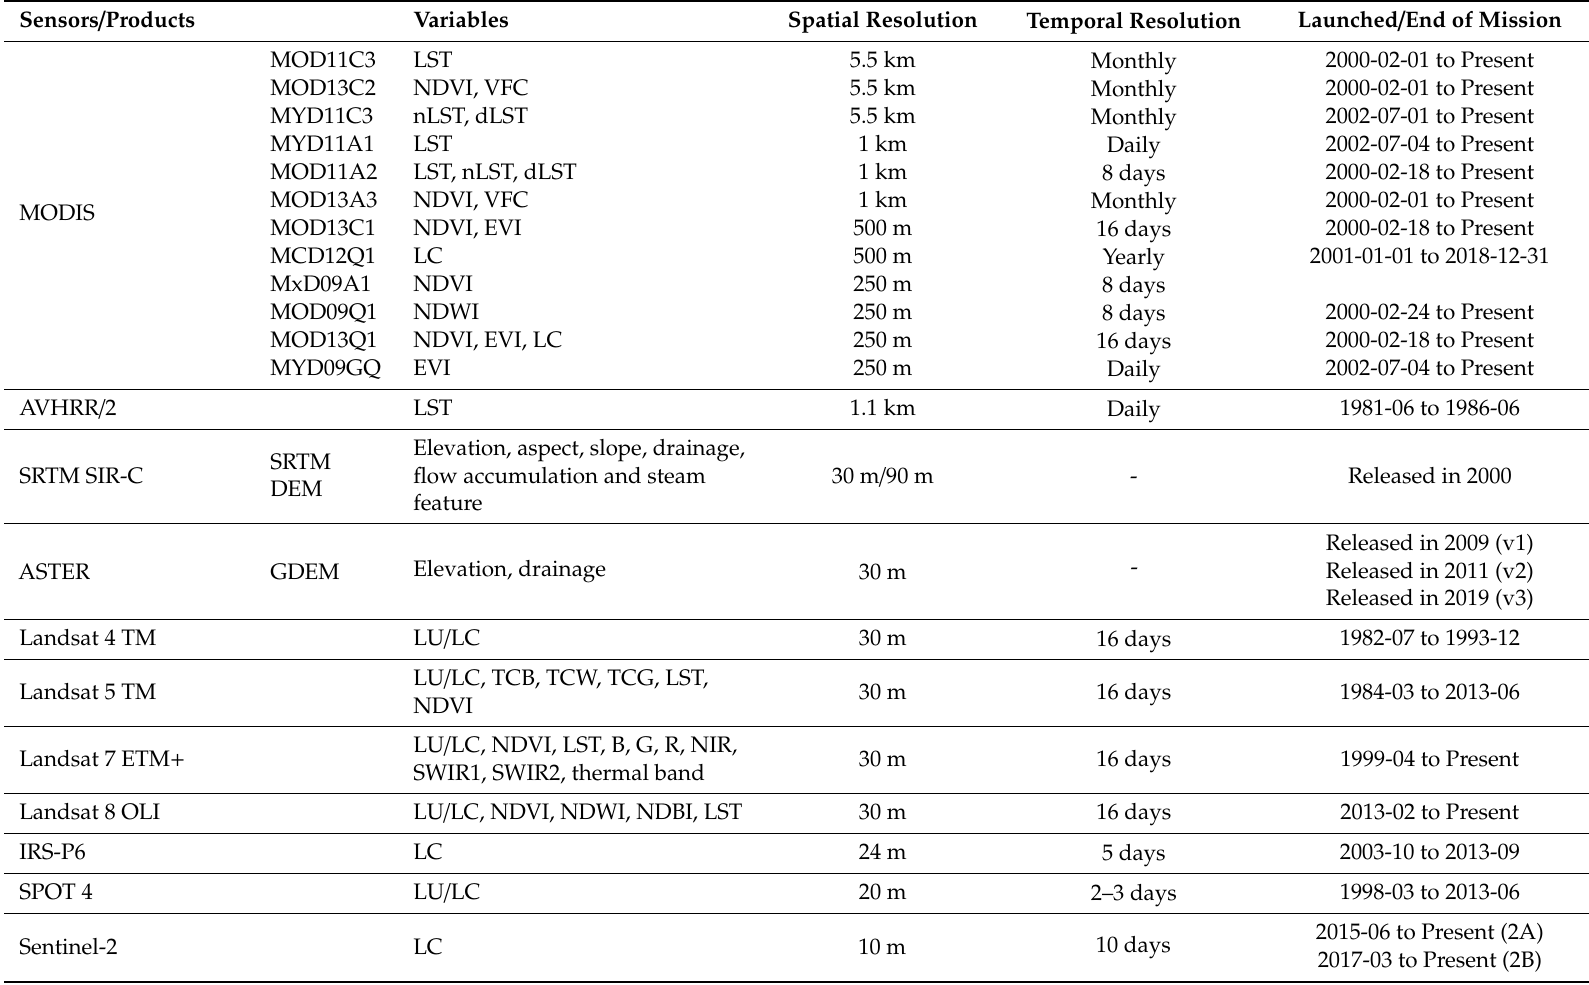
Table 4. Satellite Earth observation sensors and derived products used for identifying dengue landscape factors. Information on spatial and temporal resolution was taken from Huete et al. [27], Hamm et al. [26] and Marti et al.